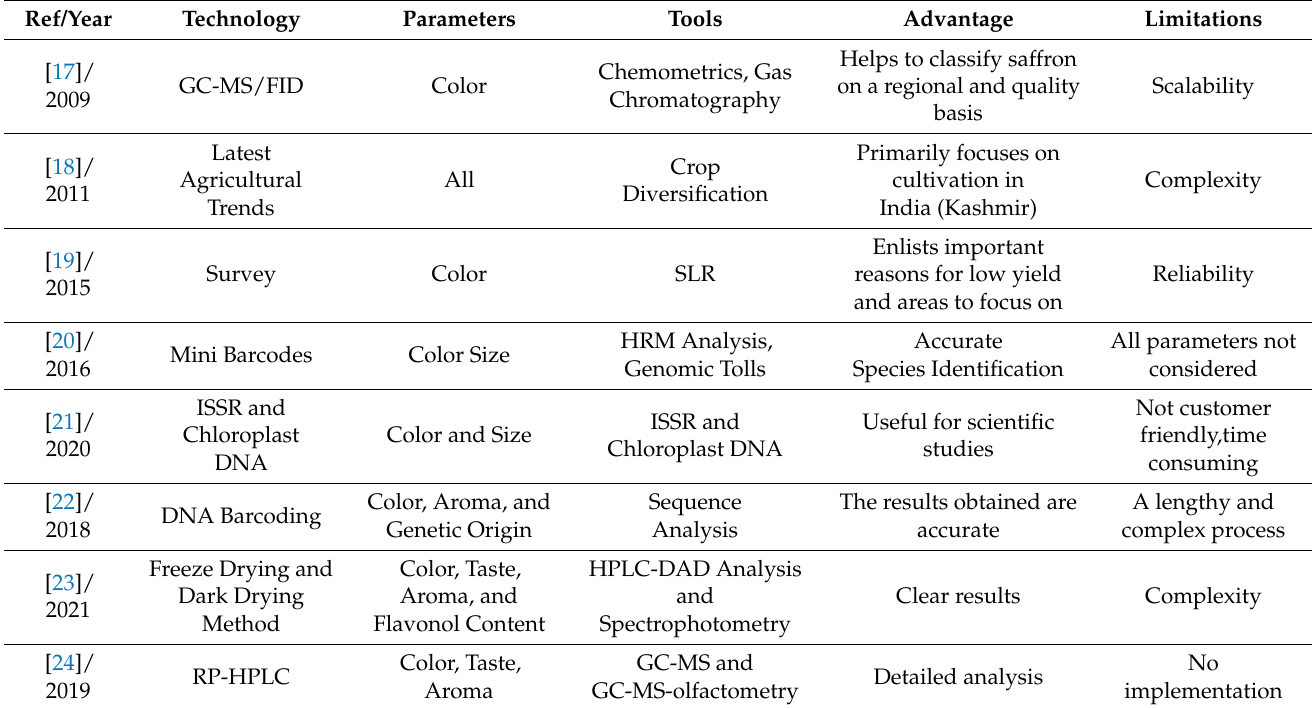
Table 1. Various saffron quality analyses and adulteration check